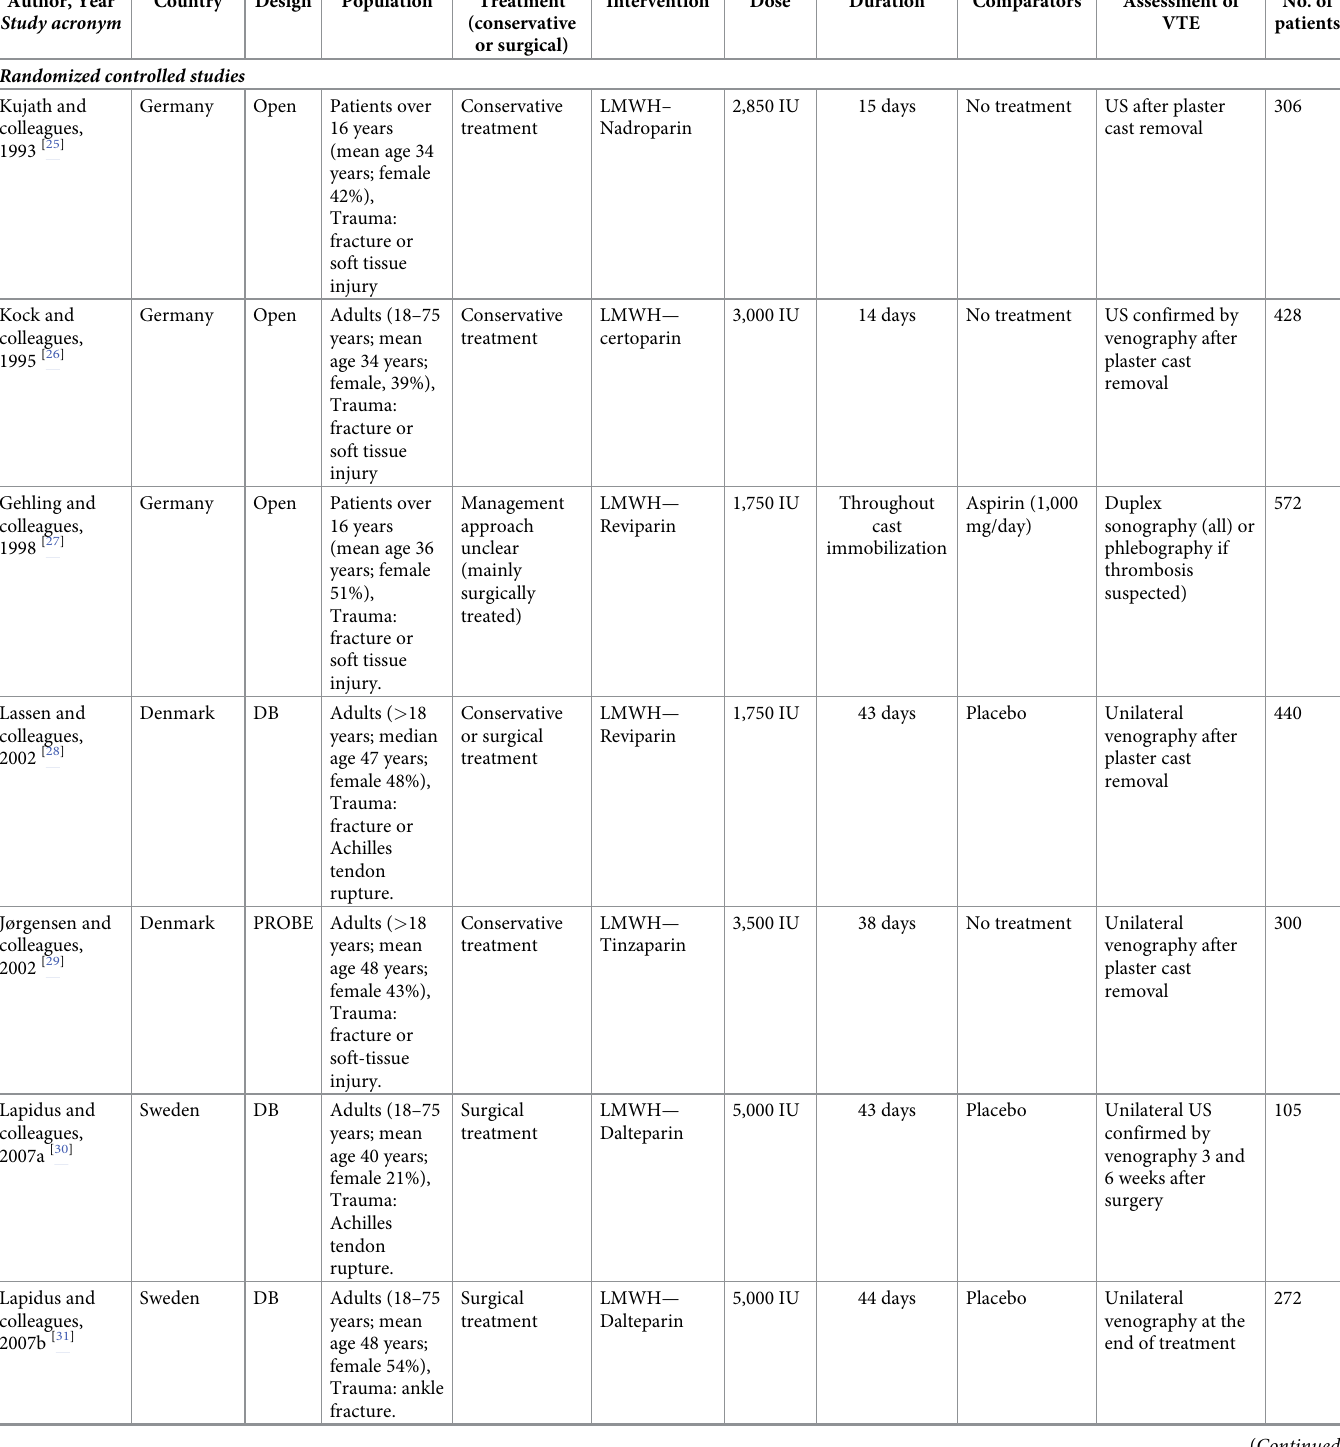
Table 1. Characteristics of included studies and patients’